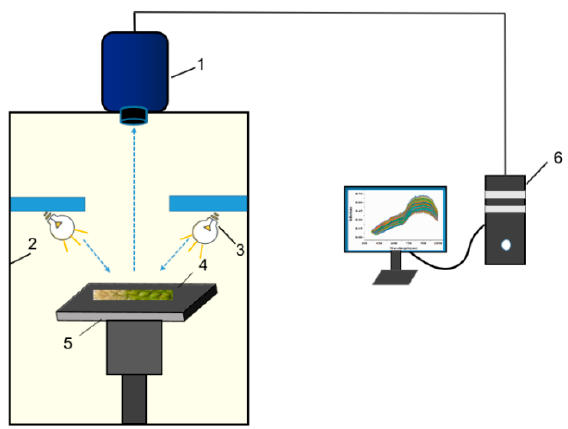
Figure 2. Composition of the hyperspectral system. (1) Imaging spectrometer; (2) Black cabinet; (3) Halogen lamp; (4) Samples; (5) Plain platform; (6) Computer.